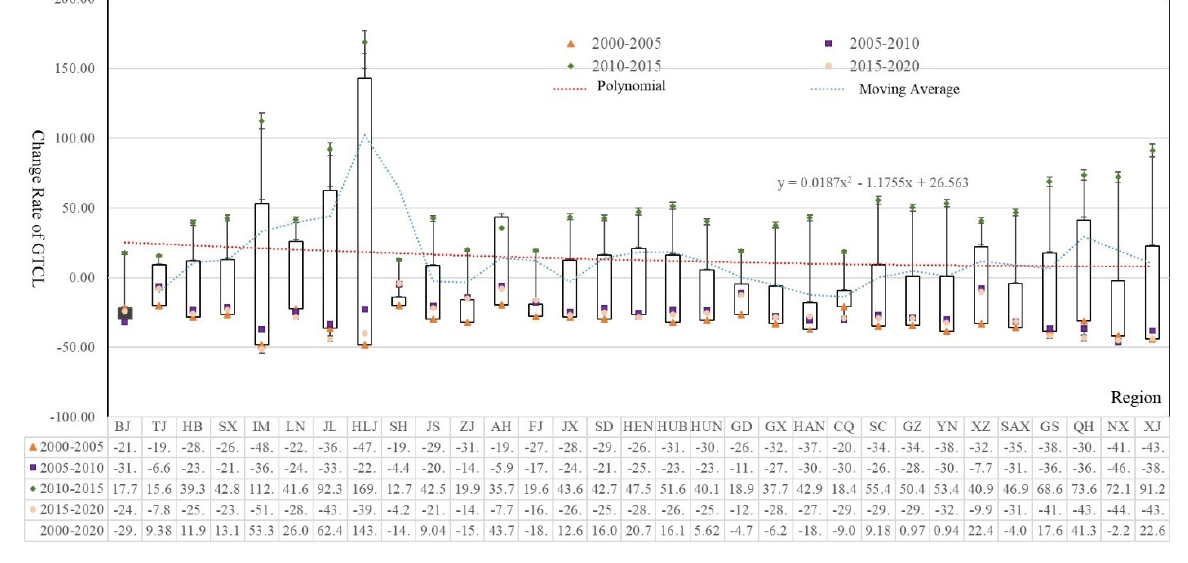
Figure 4. Change rate of GTCL in China during 2000–2020.